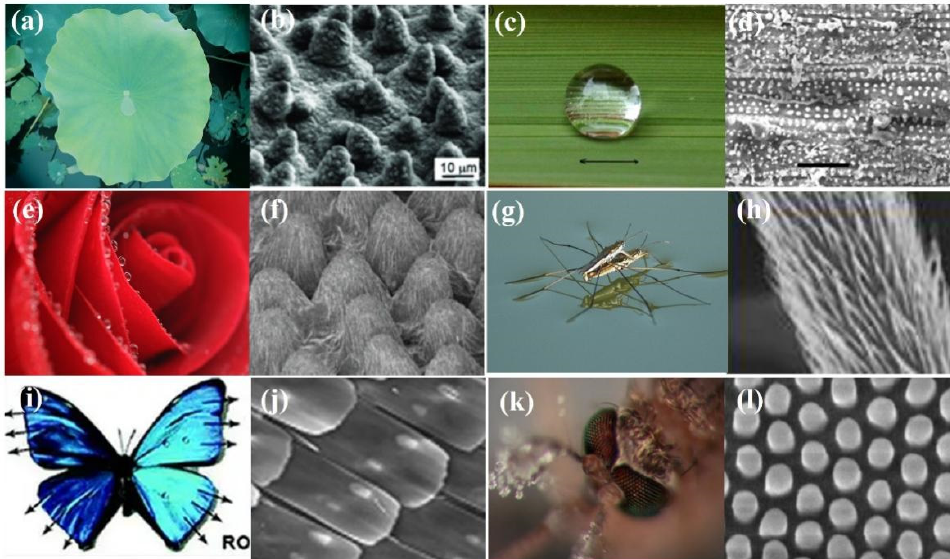
Figure 6. Diagram of organisms with wetting properties and microstructures: ( a ) Lotus leaf, ( b ) SEM of lotus leaf [86], ( c ) Rice leaf, ( d ) SEM of rice leaf [86], ( e ) Rose petal, ( f ) SEM of Rose petal [87], ( g ) Water strider, ( h ) SEM of Water strider, ( i ) Butterfly wing, ( j ) SEM of Butterfly wing, ( k ) Mosquito compound eye, ( l ) Mosquito compound eye [88].